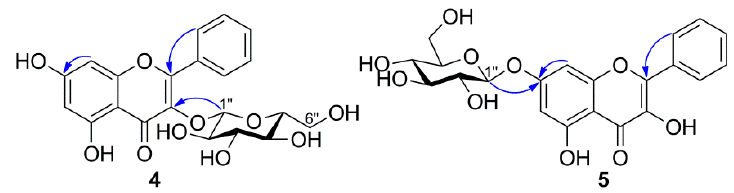
Figure 2. Key HMBC correlations ( 1 H → 13 C) of compounds 4 and 5 .